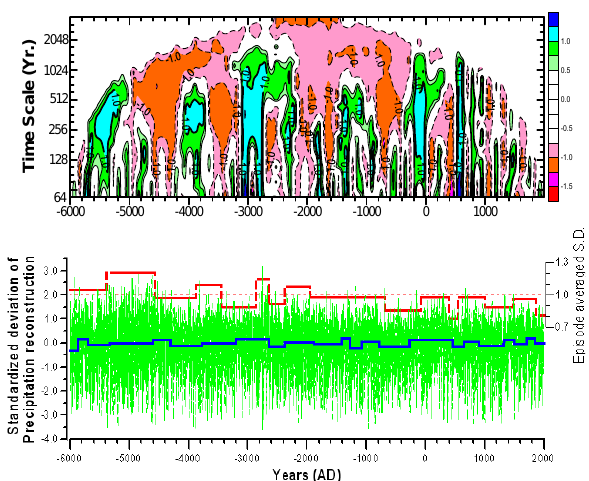
Fig. 4. (a) Contours of the index of scanning F -test on precipitation reconstruction series at 95% significance level. Contour interval is 0.25 but the zero-contour hidden. Solid lines denote positive values, dashed lines negative values. (b) change points and period averages of standard deviation (red line) from panel (a), change points and episode averages of precipitation (blue line) same as in Fig. 3b, and unfiltered precipitation reconstruction values (green dashed